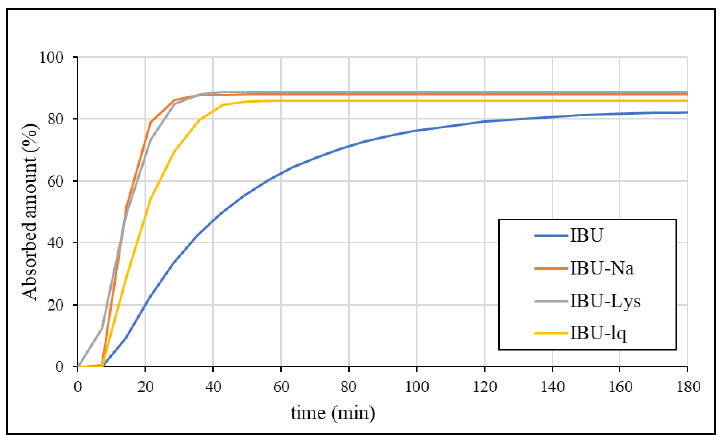
Figure 8. Published plasma concentration profiles ( a ) [23] vs. fitted curves ( b ).